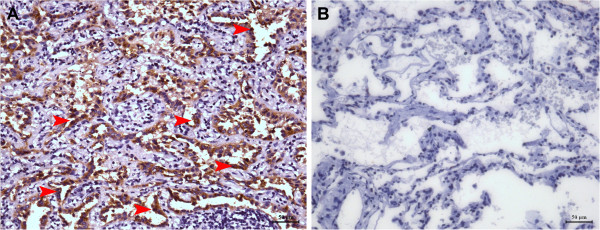
Immunohistochemical staining of CEACAM1 in primary NSCLC. (A) Representative CEACAM1 staining in tumour tissues. Arrows indicate the positive staining of neoplastic epithelium cells (brown colour, 200 × microscopic field). (B) No specific staining is visible in the section of normal cells adjacent to the tumour samples (200 × microscopic field).